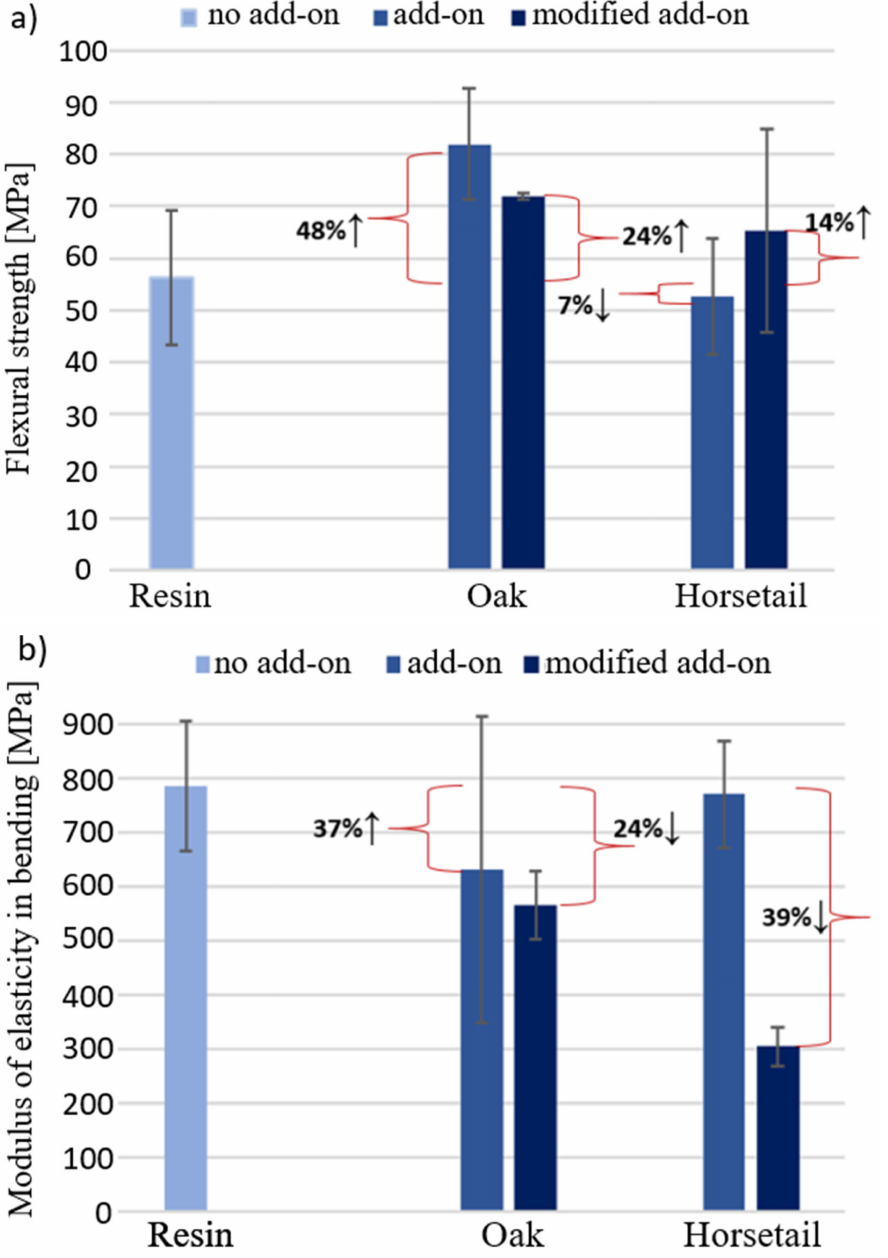
Figure 17. Bending strength ( a ) and modulus of elasticity ( b ) for samples with modified